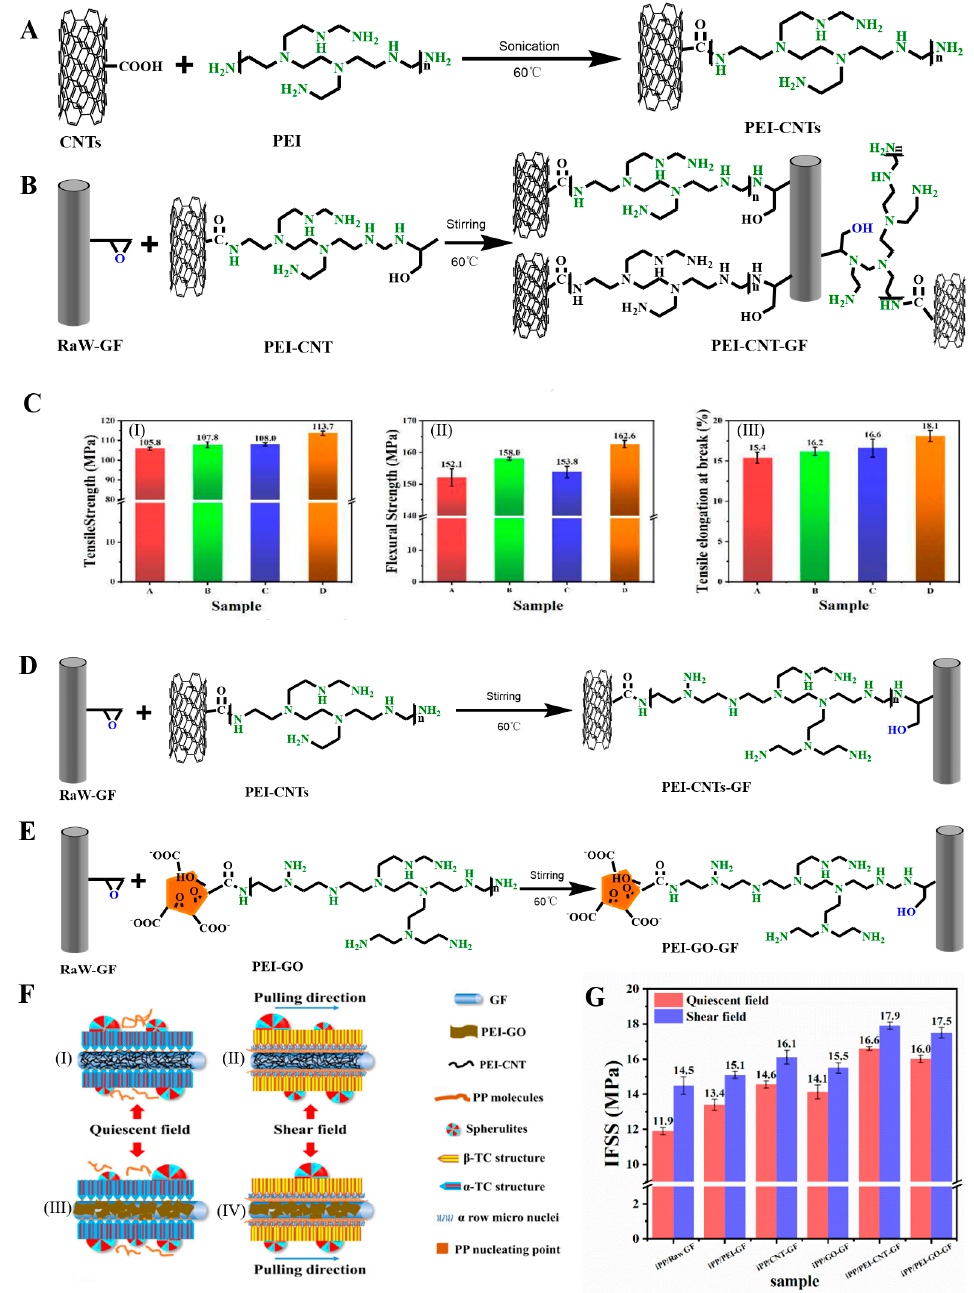
Figure 16. ( A ) Schematic diagram of PEI grafted to CNTs. ( B ) Schematic diagram of PEI − CNT reacted with GFs. ( C ) (I) Tensile strength, (II) flexural strength, and (III) tensile elongation at the break of different glass fibers reinforced with PA6 (A: PA6/Raw GF; B: PA6/PEI − GF; C: PA6/CNT − GF; and D: PA6/PEI − CNT − GF). Reproduced with permission from reference [119]. Copyright 2019 Polymer . Schematic representation of the graft reaction mechanism of ( D ) PEI − CNT on GF surface and ( E ) PEI − GO on GF surface. ( F ) Schematic diagram of mechanisms, under the quiescent condition: ( I ) iPP/PEI − CNT − GF and ( II ) iPP/PEI − GO − GF; under sheer field: ( III ) iPP/PEI − CNT − GF and ( IV ) iPP/PEI − GO − GF. ( G ) IFSS of various iPP/GFs micro − composites under quiescent and shear fields, respectively). Reproduced with permission from reference [120]. Copyright 2020 Composites Science and Technology .